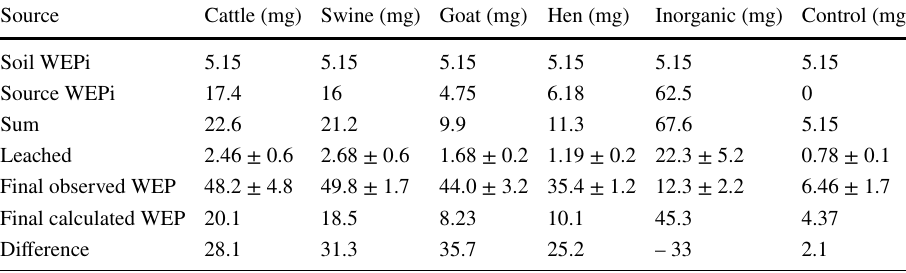
Table 6 WEP balance in the 20-cm columns with Dystric Xeropsamments treated or not with organic and inorganic sources with 62.5 mg of total